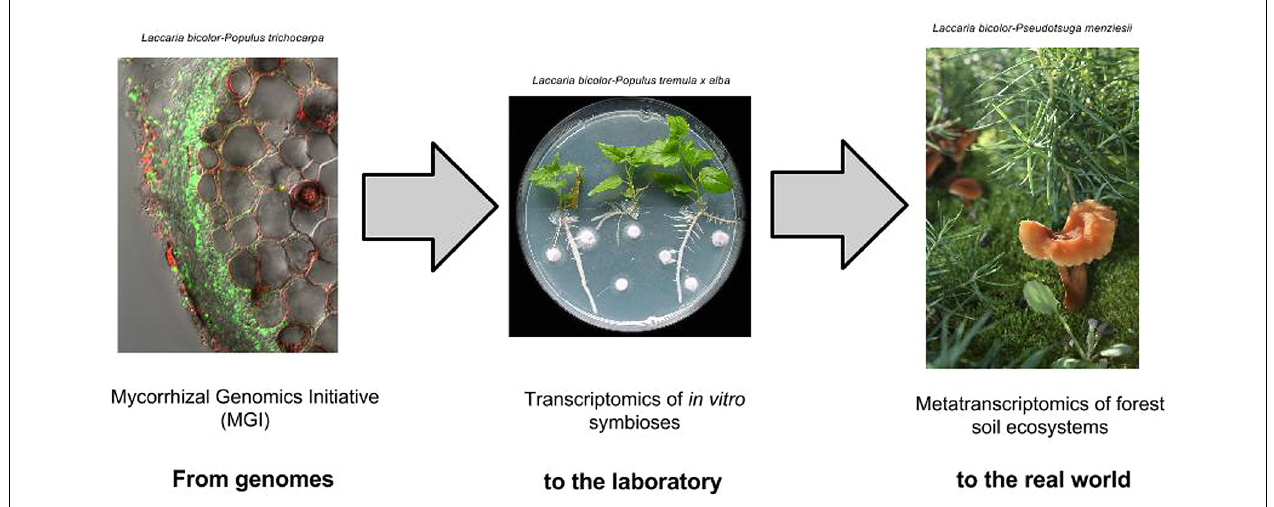
FIGURE 1 | From sequence to function of symbiotic genes. Understanding evolution and function of mycorrhizal interactions can be driven by large scale genomics, transcriptomics and metatranscriptomics studies.